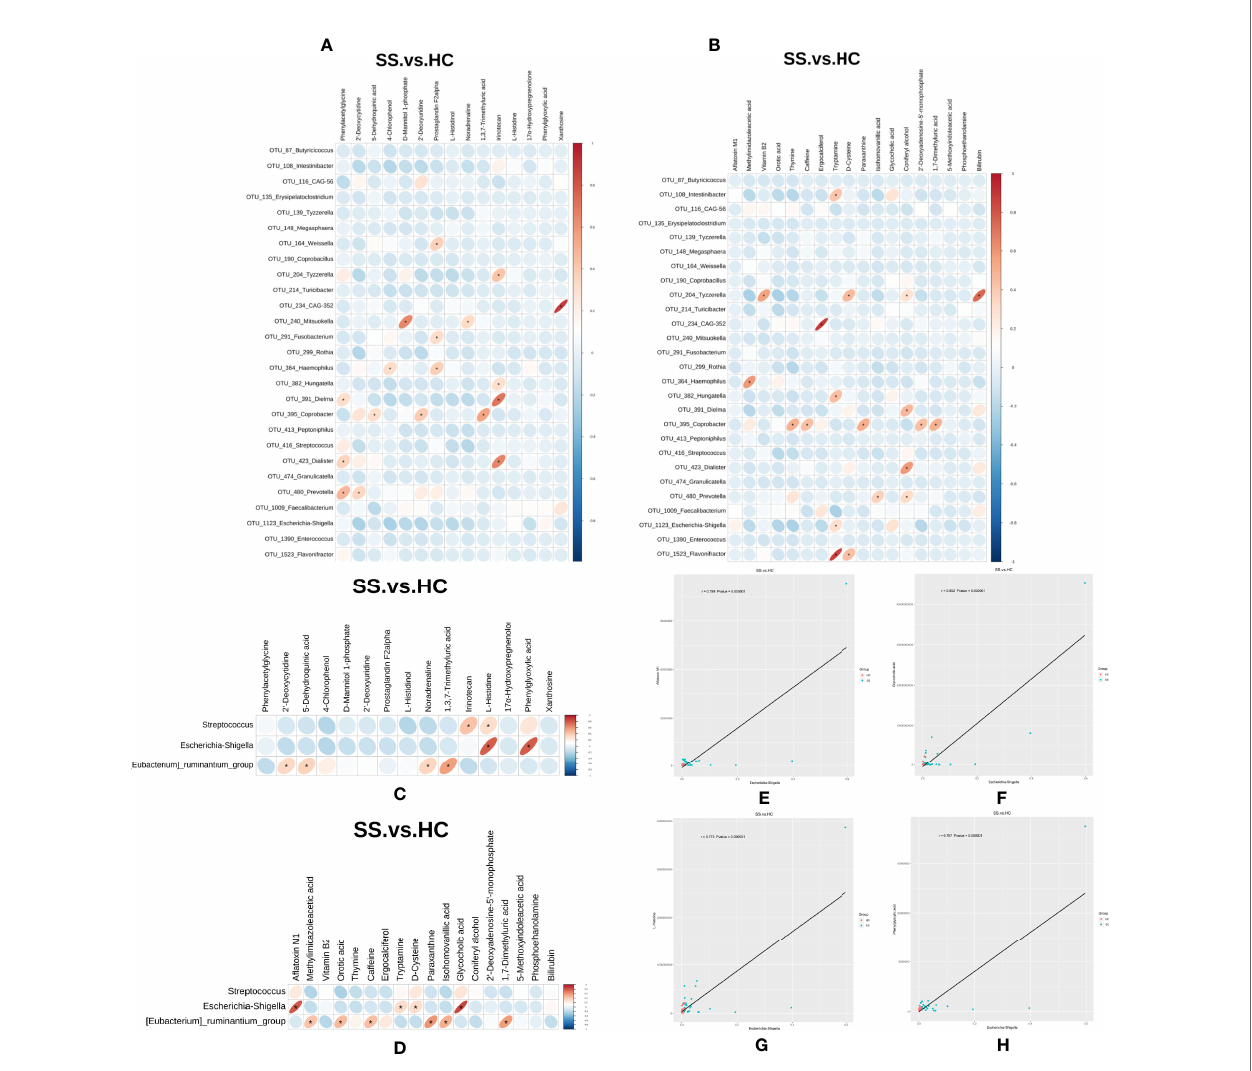
FIGURE 6 | Cross-correlation analysis between microbiota and metabolites. (A, B) Heatmap of the correlation between the top 28 OTUs with statistical difference annotated at the genus level and metabolites in the ESI- and ESI+ ion modes. (C, D) Heatmap of the correlation between the three microbiotas in genus level and metabolites in the ESI- and ESI+ ion modes. The horizontal coordinate represents the differentially abundant bacteria at the level of the 16S gene, and the vertical coordinate represents the differentially abundant metabolites. Red indicates a positive correlation, blue indicates a negative correlation, and an asterisk (*) indicates statistical signi fi cance, that is, P < 0.05. (E – H) Scatter plot of the correlation between Escherichia-Shigella and four metabolites (a fl atoxin M1, glycocholic acid, L- histidine and phenylglyoxylic